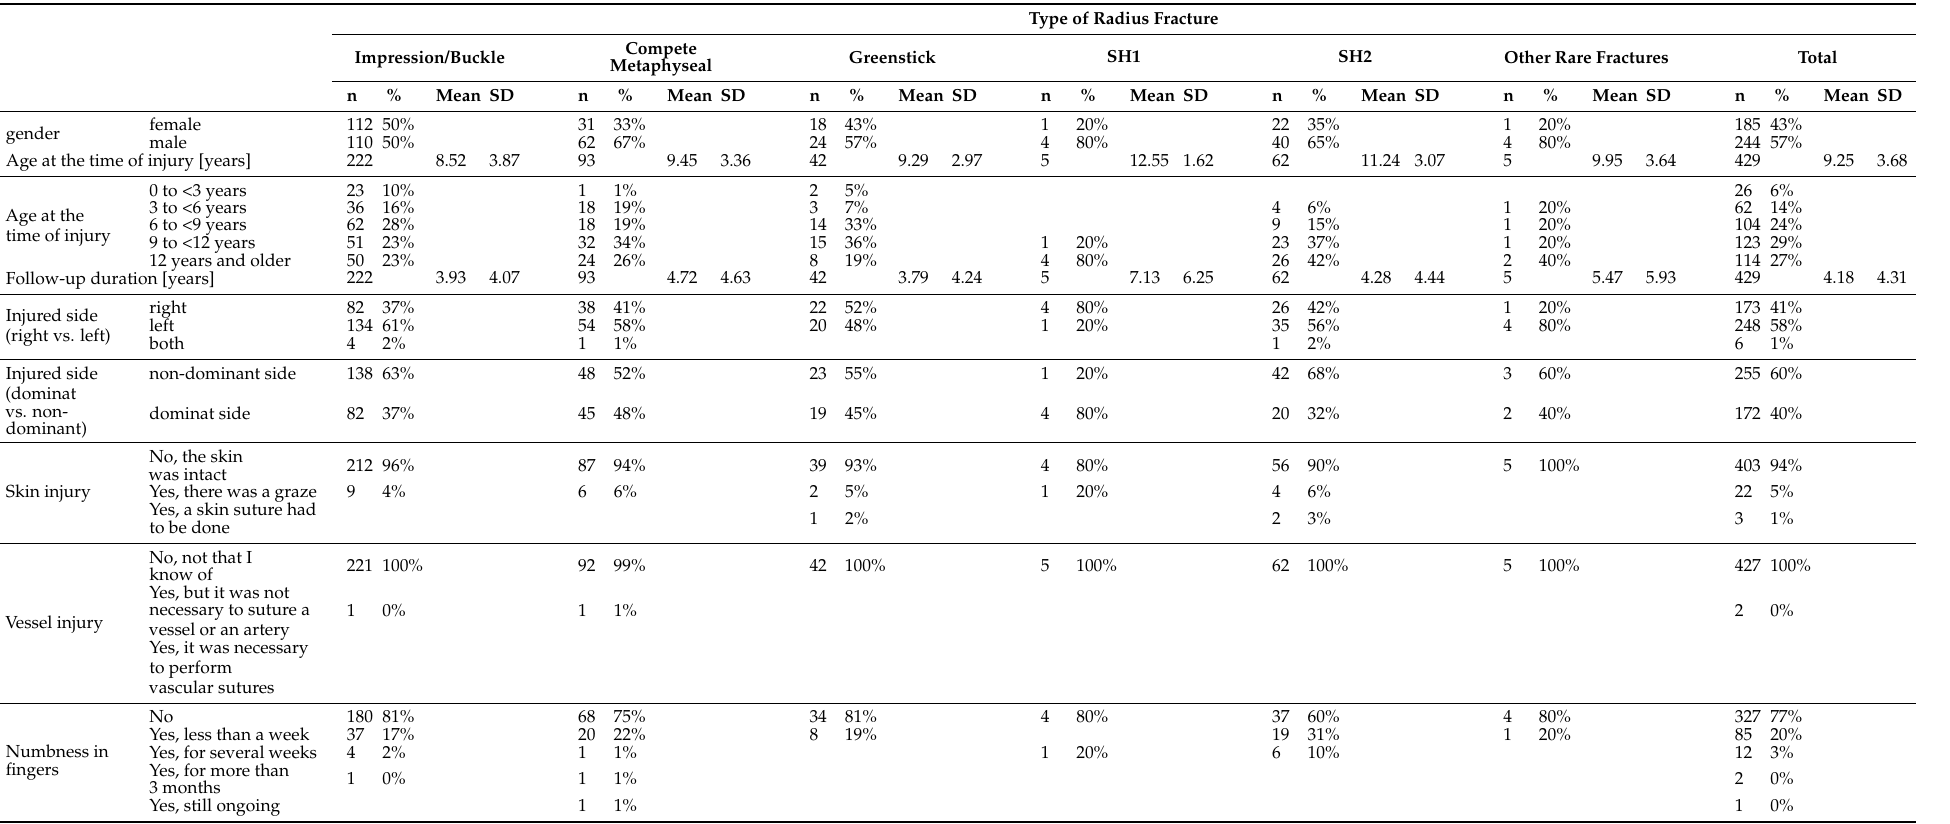
Table 1. Baseline